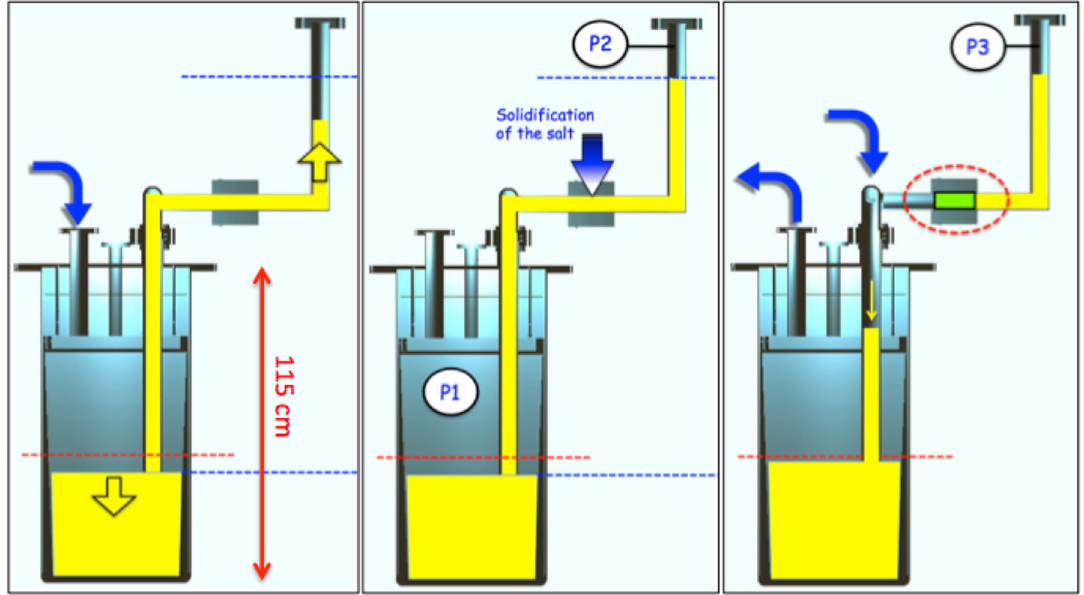
Fig. 4. Sequences of cold plug formation in the simpli fi ed con fi guration, left: rise of the molten salt in the pipe above the plug, middle: salt level kept constant and cooling of the plug, right: release of tank pressure and gas injection to drain the molten salt left below the plug.